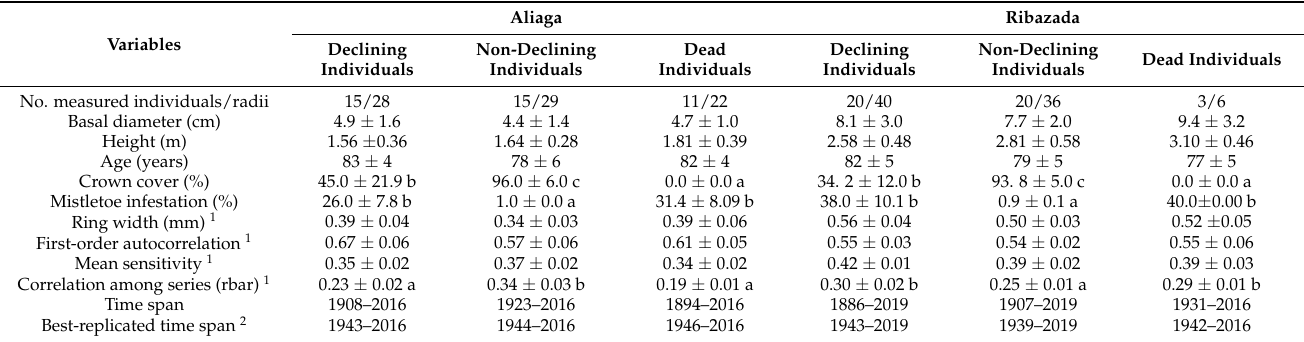
Table 1. Size and growth data of sampled junipers. Mistletoe infestation refers to the percentage of the juniper crown covered by mistletoe individuals. Values are means ± SE. Different letters indicate significant ( p < 0.05) differences between health classes within each site according to Mann–Whitney